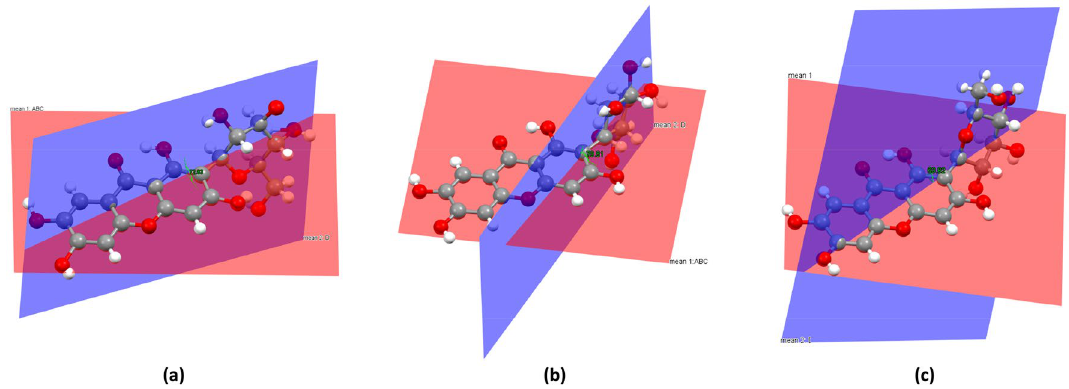
Fig. 2 The dihedral angles of two polymorphs of mangiferin, where a was for mangiferin molecule in form I, b , c were for two molecules in form II